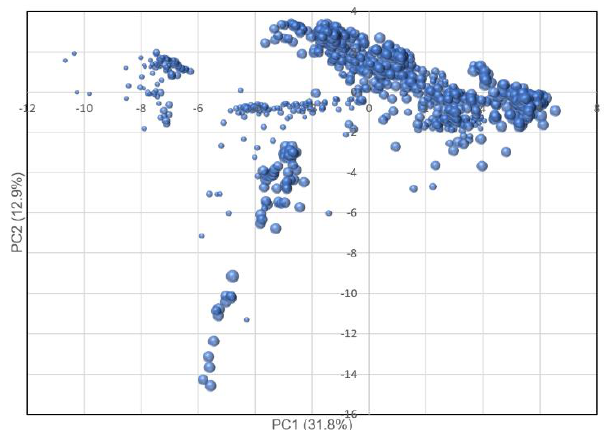
Figure 8. Projection of the samples in dataset (iii) into the subspace of the two first principal components, PC1 and PC2. The size of the points is proportional to the corresponding ETo values.